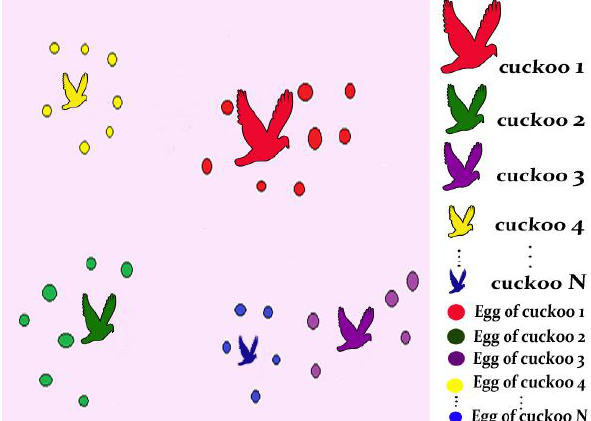
Figure 1. Results of egg-laying based on randomized policy in classical version of cuckoo algorithm.